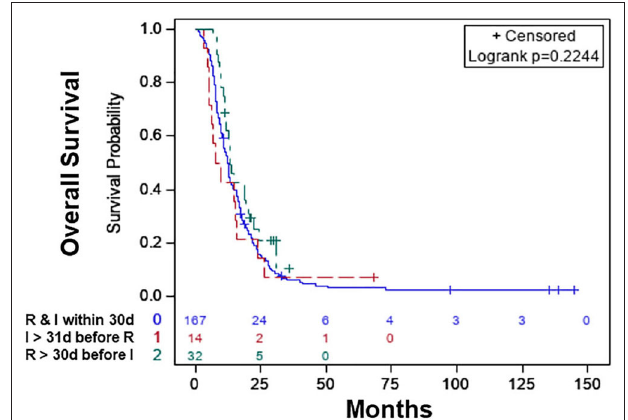
FIGURE 3 | Overall survival of patients with radiation therapy plus immunotherapy with or without chemotherapy: radiation therapy and immunotherapy started within 30 days of each other (blue), immunotherapy started > 30 days before the start of radiation therapy (red), radiation therapy started > 30 days before the start of immunotherapy (green).